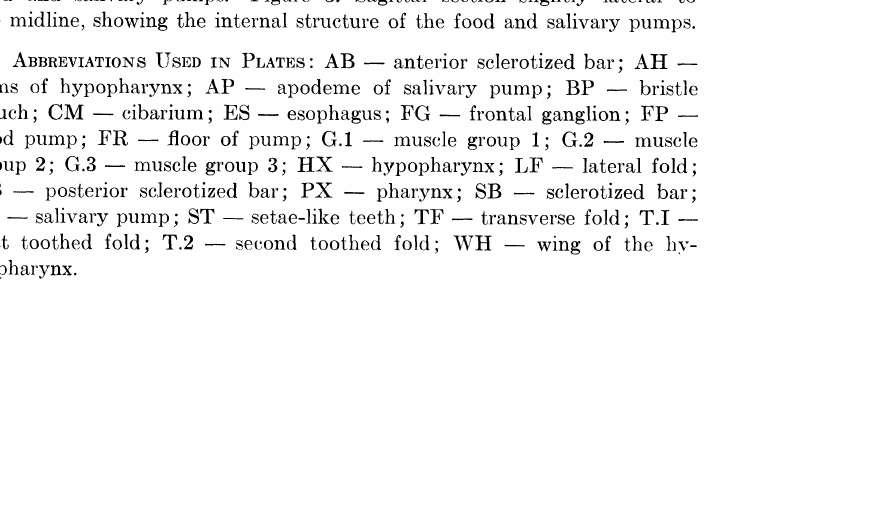
Figure 1. Composite stereo- gram showing structure of pump and relationship with the rest of the head. Figure 2. Parasagittal section showing the lateral aspects of the food and salivary pumps. Figure 3. Sagittal section slightly lateral to the midline, showing the internal structure of the food and salivary